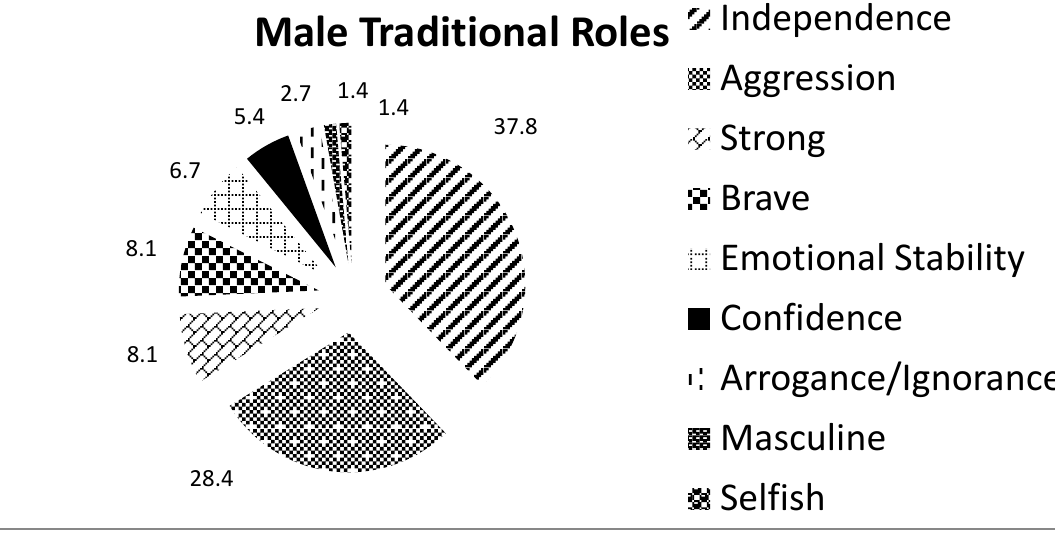
Featured male traditional roles in male characters. To assist in this chart’s comprehension, the roles have been organized clockwise: “Independence” begins with the largest portion with diagonal lines, followed by “Aggression”, etc. going clockwise on the chart.